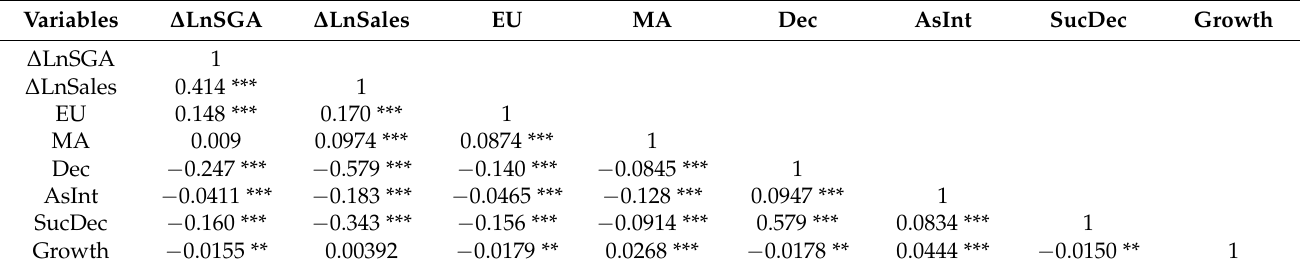
Table 5. Correlation